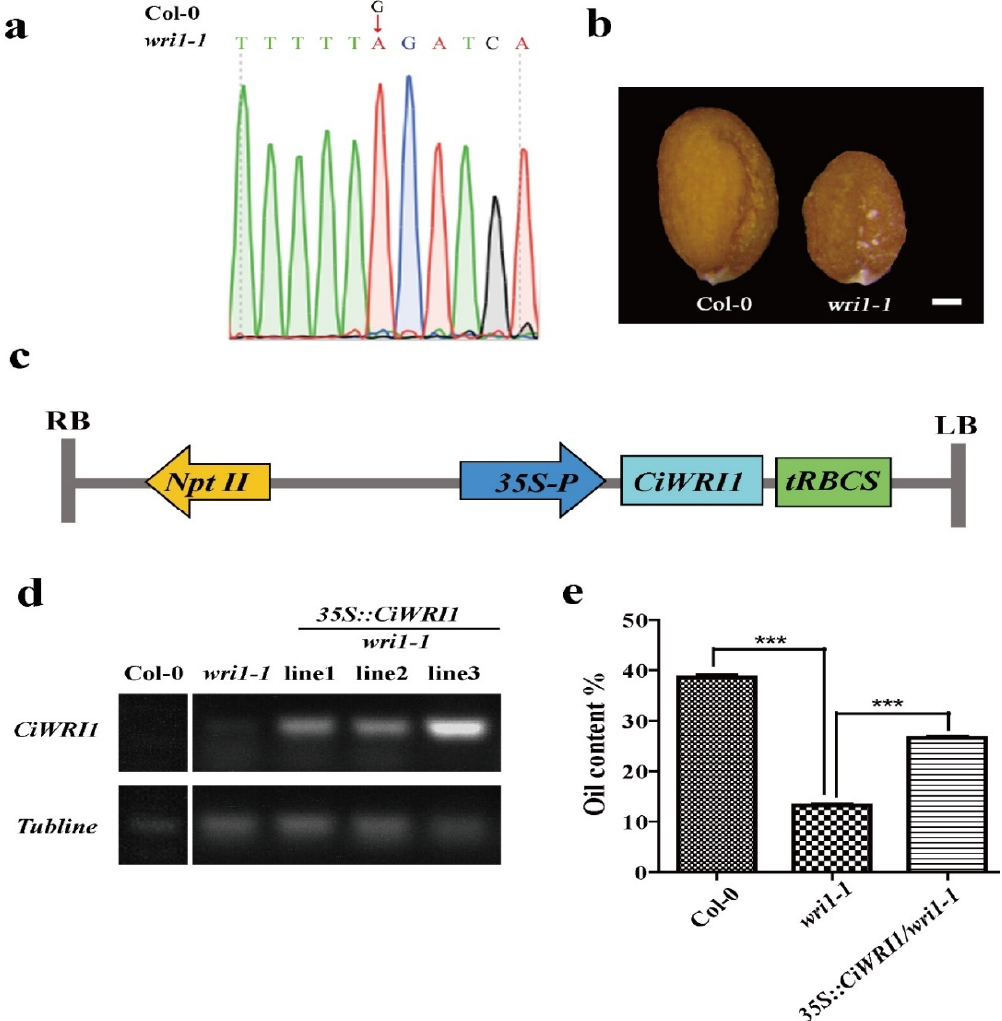
Figure 4. Complementation of CiWRI1 in wri1-1 mutants. ( a ) identification of the wri1-1 mutant of Arabidopsis . ( b ) Seed phenotypes of wild-type and wri1-1 mutant plants. ( c ) Schematic of vector construction for CiWRI1 overexpression in the wri1-1 mutant of Arabidopsis . ( d ) Expression of CiWRI1 in three individual p35 S: CiWRI1/wri1-1 transgenic plants in the T1 generation detected by semiquantitative RT-PCR. ( e ) Oil content of seeds from wild-type, wri1-1 mutant, and p35 S: CiWRI1 / wri1-1 transgenic plants. Seeds from three independent p35 S: CiWRI1/wri1-1 transgenic plants were used for lipid analysis. N = 3 for each genotype with about 2.4 g seeds for each analysis. *** p < 0.001 (Student’s t test). Scale bar in, Bars = 100 μm ( b ).